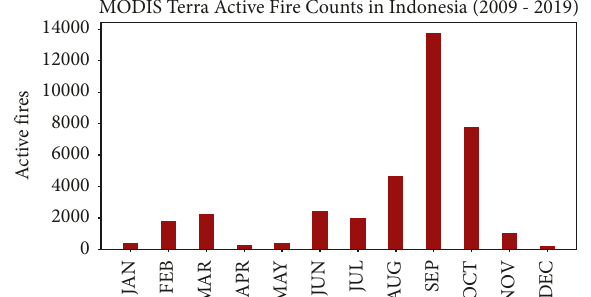
Figure 8: The monthly average of the MODIS Terra active fire counts in Indonesia during the period 2009 to